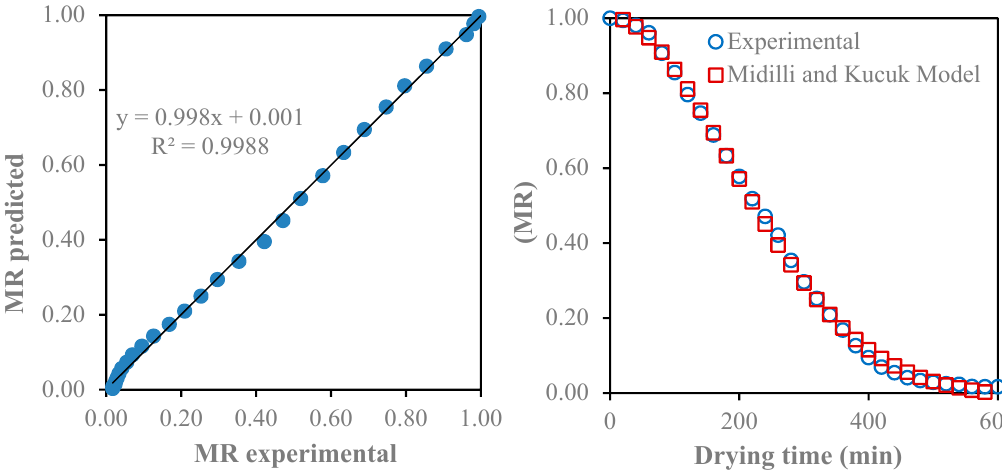
Figure 5. Validation of experimental and predicted moisture ratio values from the Midilli and Kucuk model.